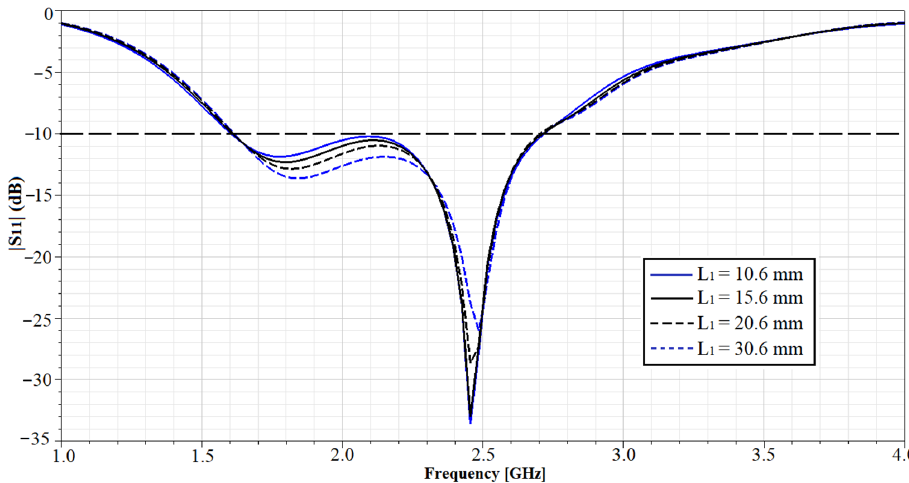
Figure 6. Variation of reflection coefficient |S 11 | with respect to the length L 1.